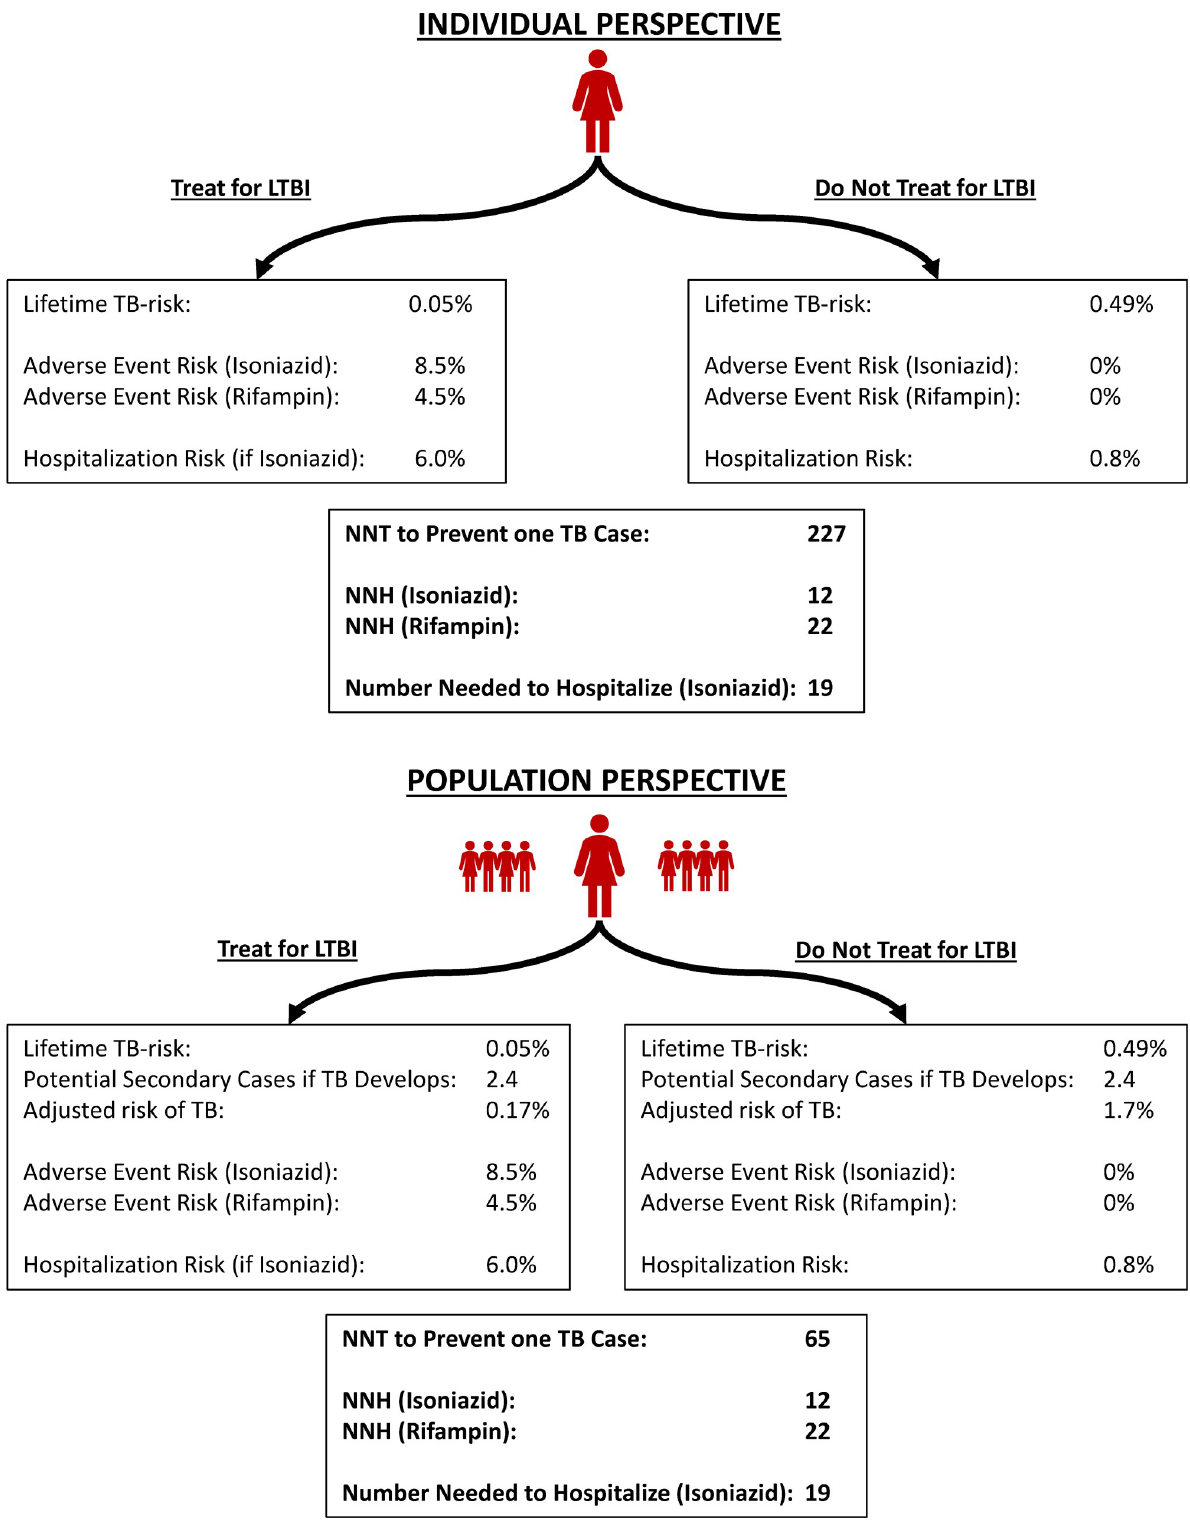
Fig 2. Risk–Benefit Considerations for Treatment of LTBI. Shown are the expected outcomes of treatment for LTBI versus no LTBI treatment. The individual is a 75-year–old woman with a 5-year life expectancy and a positive interferon-gamma release assay who immigrated to Canada from the